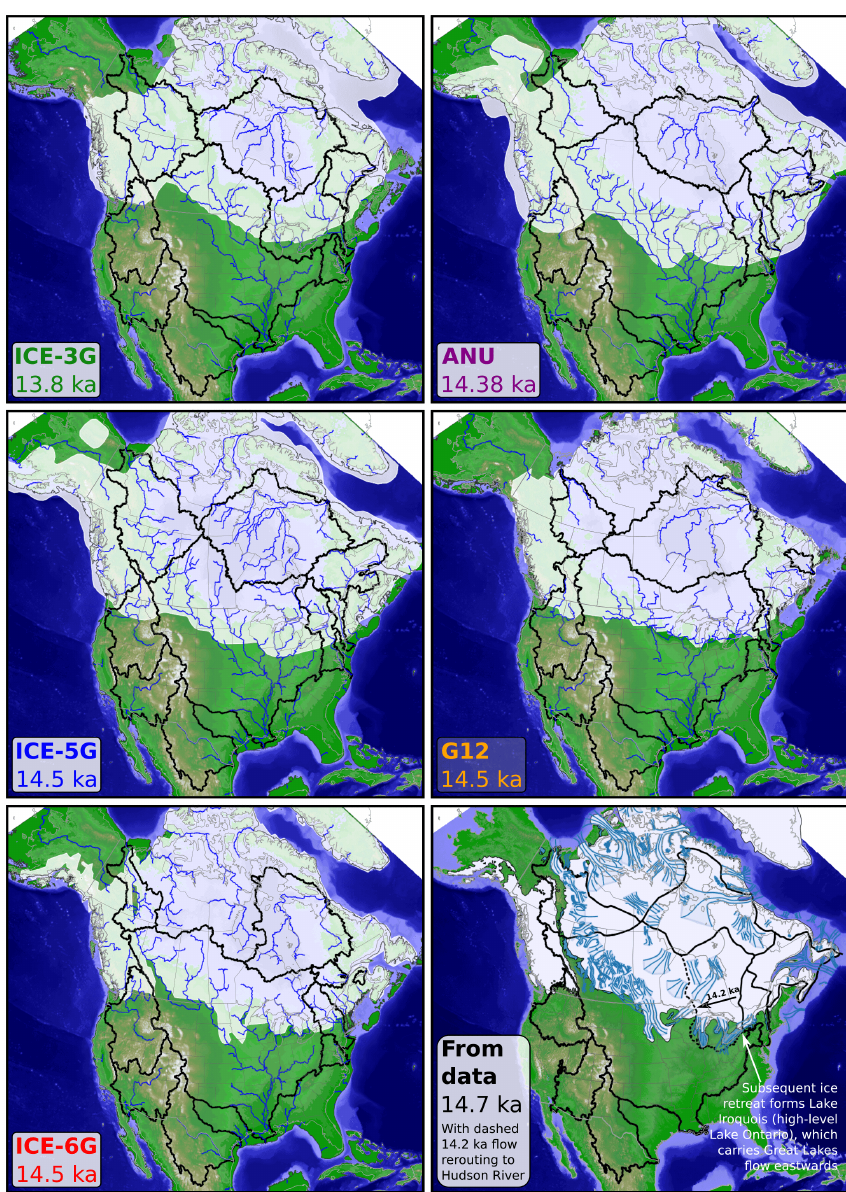
Figure 8. Bølling–Allerød warm period and (for all but ICE-3G and the data-driven reconstruction, for which the closest-available time slice(s) was/were chosen) Meltwater Pulse 1A. The Bølling–Allerød was the major period of warming between earlier near-LGM conditions and later Younger Dryas cooling. The early part of the Bølling–Allerød, the Bølling warming, encompasses MWP-1A, a period of 14–18m sea-level rise between 14.65 and 14.31ka (Deschamps et al., 2012). Collapse of the ice saddle between the Laurentide and Cordilleran ice sheets at this time, combined with generally enhanced melt rates due to the Bølling warming, could be the mechanism for rapid sea-level rise during MWP-1A (Gregoire et al., 2012, 2016; Gomez et al., 2015). Note the extension of the blue ≥ 1000m 3 s − 1 river lines for many of the ice models; this is representative of an increase in melt that increases river